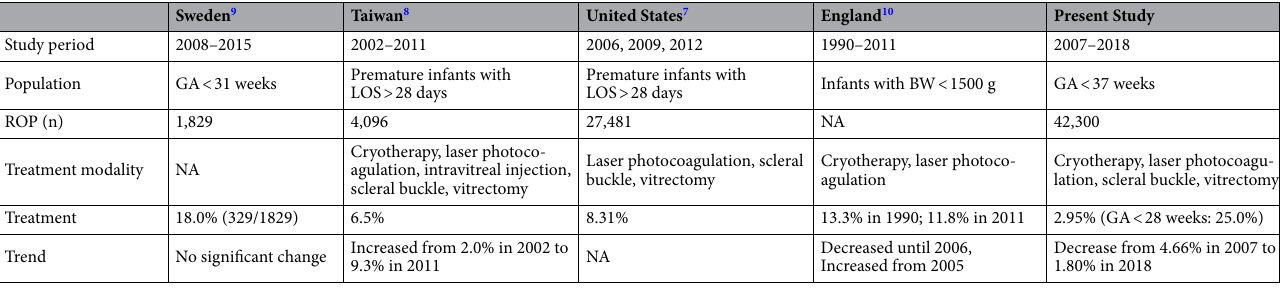
Table 4. Nationwide studies of treatment in retinopathy of prematurity including retinal ablation and surgery in the last 10 years. GA gestational age, LOS length of hospital stay, ROP retinopathy of